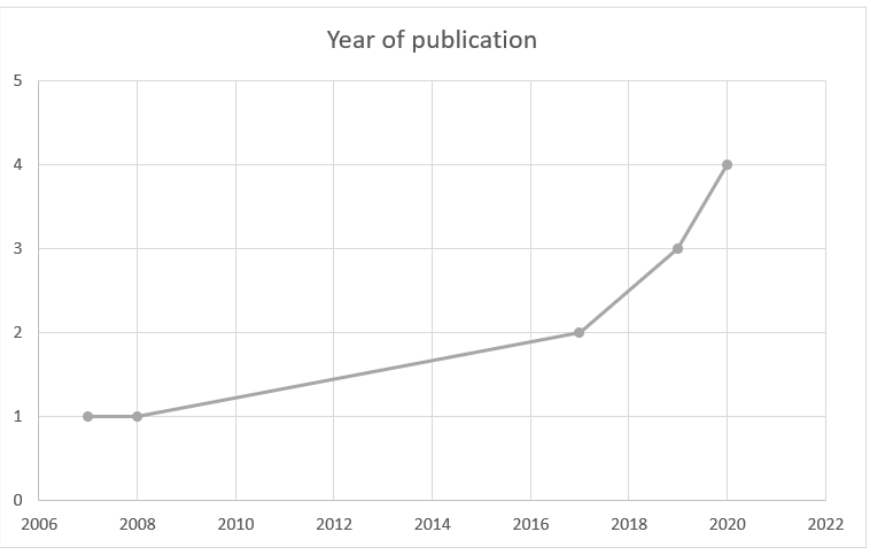
Figure 2. Year of publication.